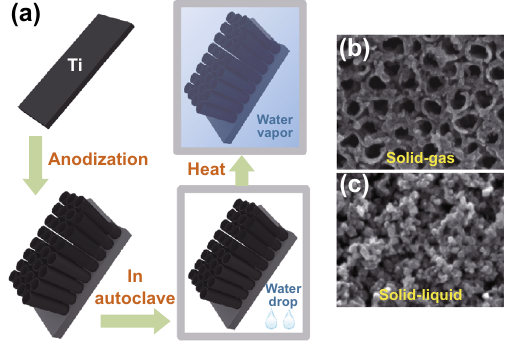
Fig. 5 a Flowchart for the low-temperature crystallization of amor- phous TiO 2 nanotubular arrays by solid–gas reaction. In a Teflon- lined stainless autoclave, the as-anodized amorphous TiO 2 nanotubes fabricated by anodization reacted with water vapor to yield anatase phase. Morphology images of TiO 2 nanotubular arrays prepared by anodizing Ti foil at 20 V for 20 min in 0.5 wt% HF solution, followed by b hydrothermal solid–gas crystallization and c hydrother- mal solid–liquid crystallization at 160 (cid:3) C for 4 h [54]. Copyright (cid:2) 2013 The Royal Society of